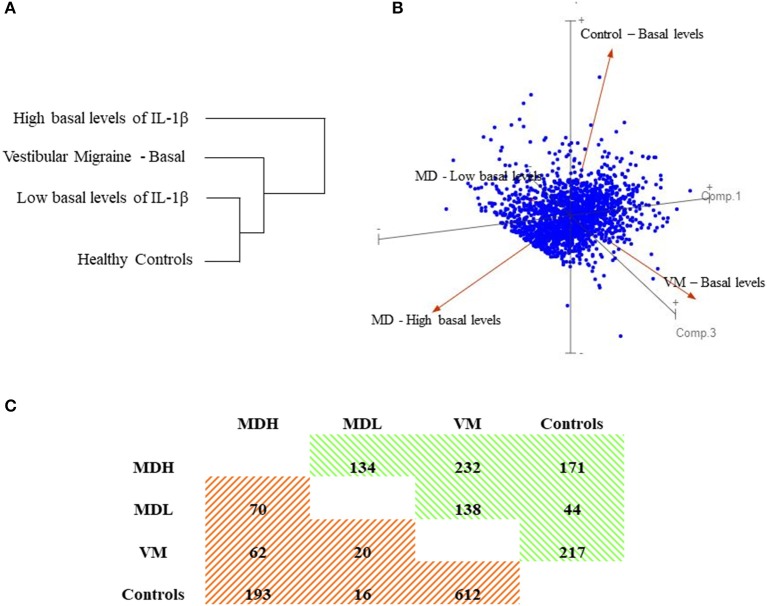
Gene expression in PBMC. (A) Dendrogram showing hierarchical clustering of patients and controls according to the gene expression in PBMC. (B) Three-dimensional loading plot showing principal component analysis (PCA) using all datasets. (C) Matrix of up- and down- regulated genes for selected pairwise comparisons. Values indicate the number of up- or down- regulated genes with a fold-change (FC) >2 and P-value < 0.02. In green are the up-regulated genes (positive FC) and in orange are the down-regulated genes (negative FC).